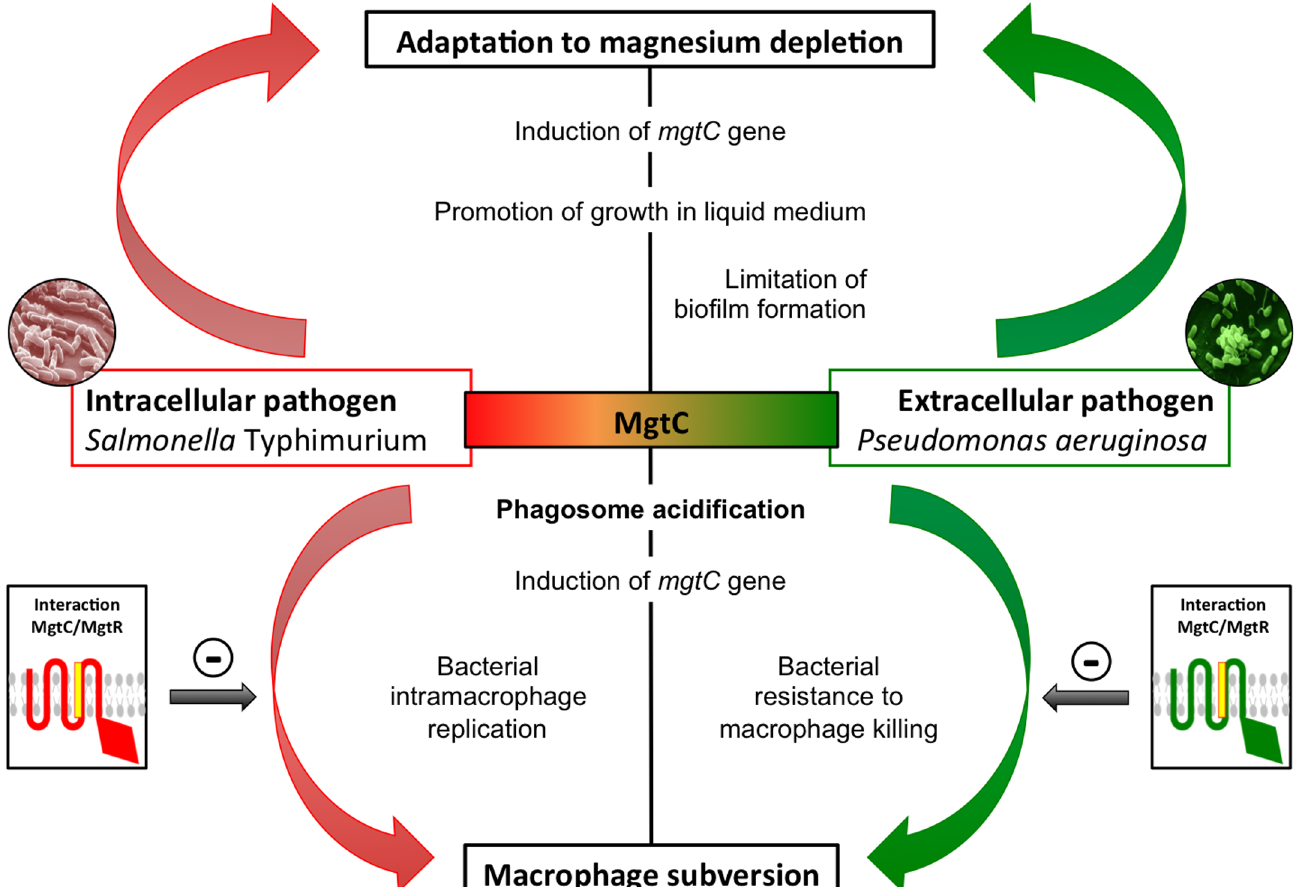
Fig 9. Role of MgtC in intracellular and extracellular pathogens. MgtC is involved in adaptation to magnesium deprivation and macrophage subversion both in intracellular and extracellular pathogens. We propose that MgtC share a similar function in intracellular and extracellular pathogens and that the bacterial lifestyle determines whether MgtC will promote intramacrophage bacterial multiplication or resistance to killing by macrophages. Expression of mgtC gene is induced in macrophages and phagosome acidification contributes to its optimal expression. The MgtR peptide can interfere with MgtC function, thus acting as a natural antagonist, and its production limits the macrophage